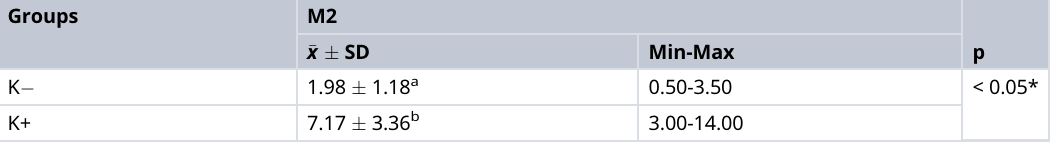
Table 2. M2 count in K (cid:2) & K+ groups.